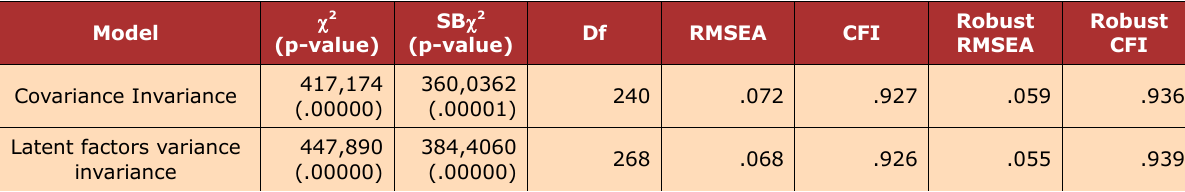
Table 12. Goodness of fit indexes for errors variance invariance of latent factors